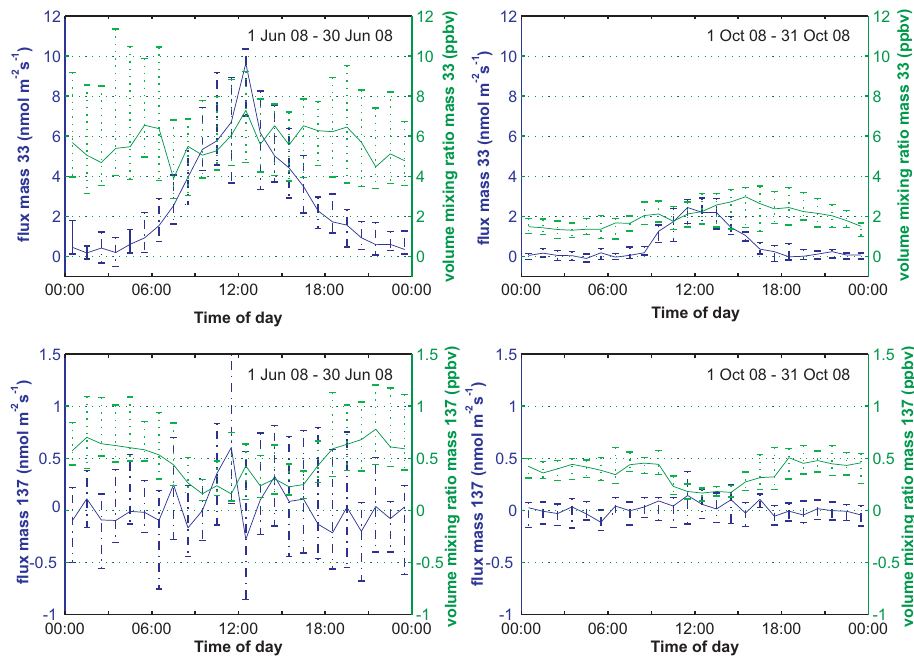
Fig. 8. Median diurnal cycles of methanol (upper panels) and monoterpene (lower panels) volume mixing ratios (green lines) and fluxes (blue lines) including the 25% and 75% percentiles for the months June and October 2008.